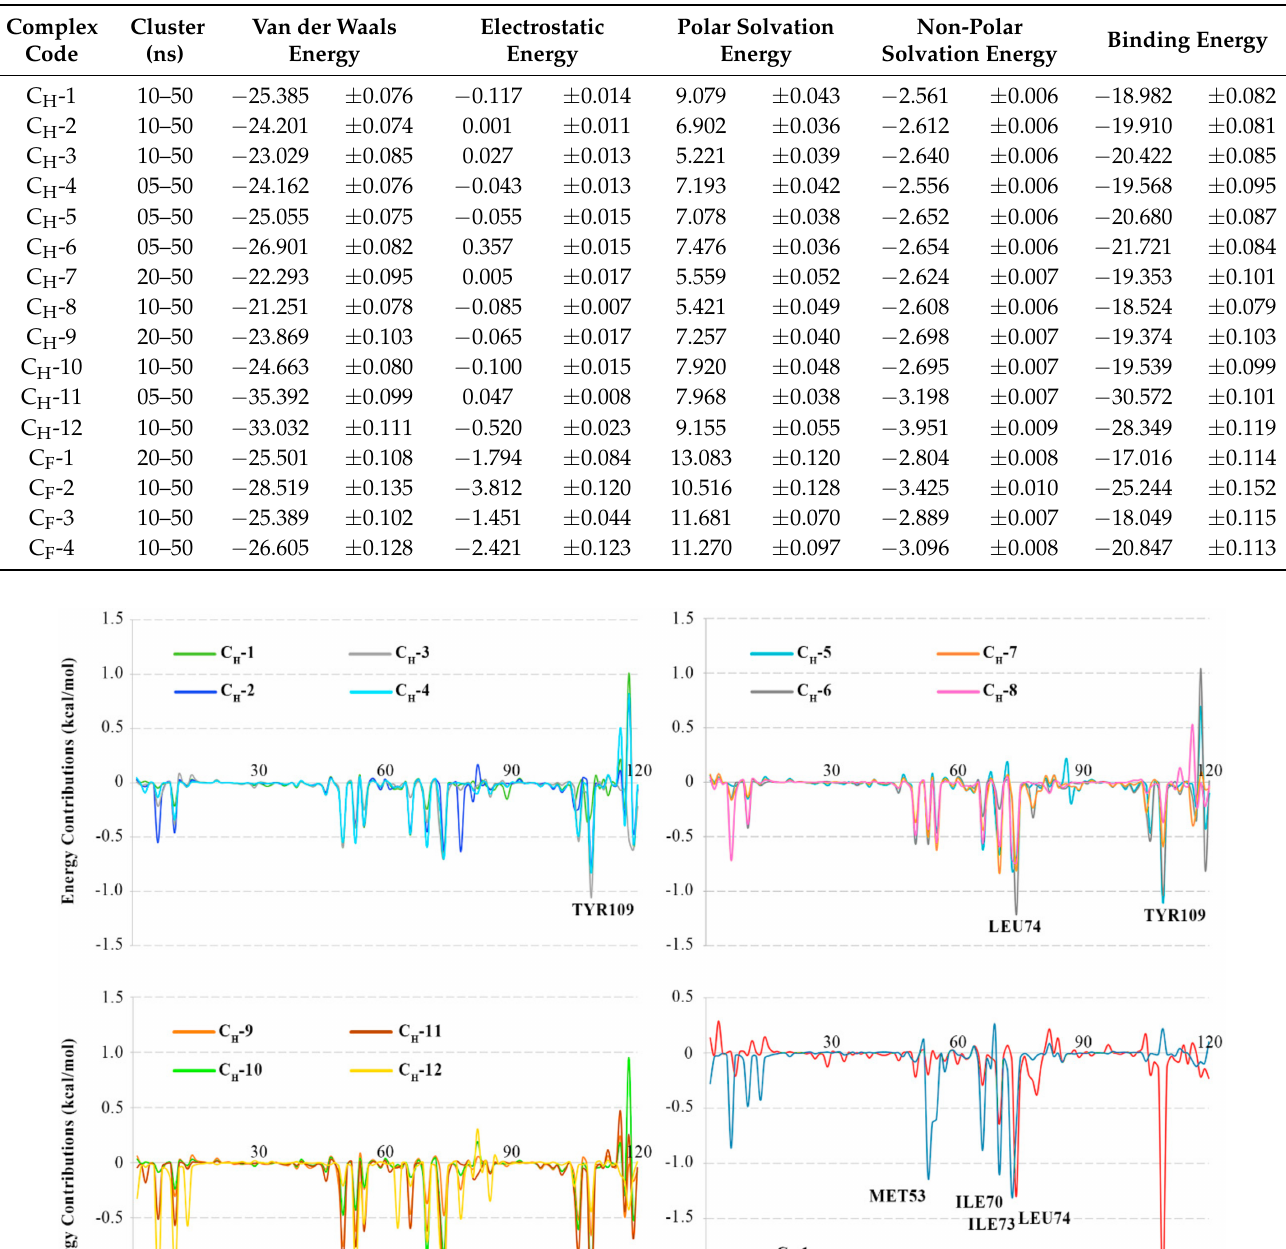
Table 3. The free binding energy of SnocOBP12–ligand complexes. (Energy: kcal/mol).